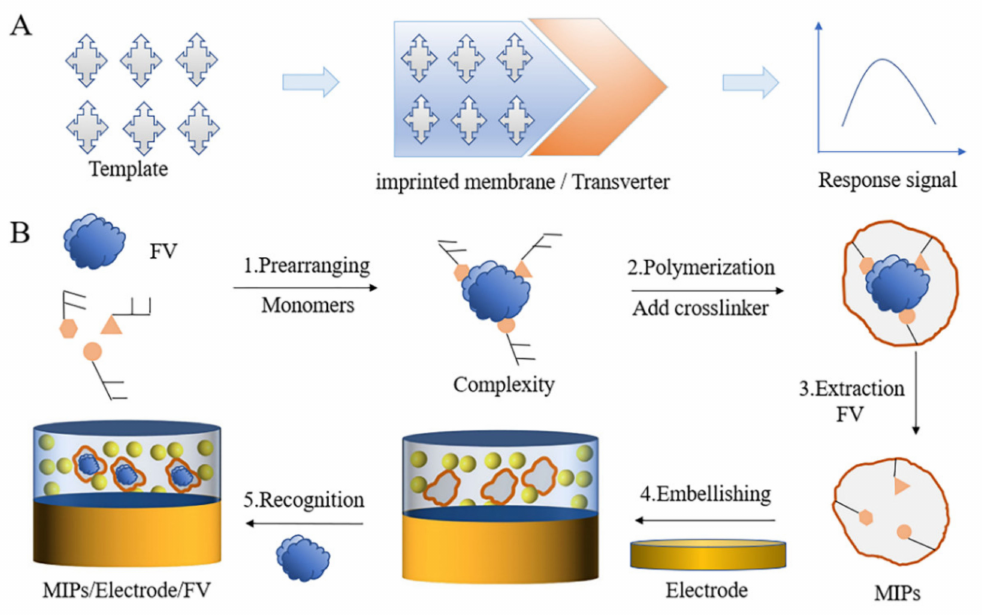
Figure 6. ( A ) The working principle of the molecularly imprinted sensor; ( B ) A molecularly imprinted sensor that specifically recognizes FV (this figure was adopted from